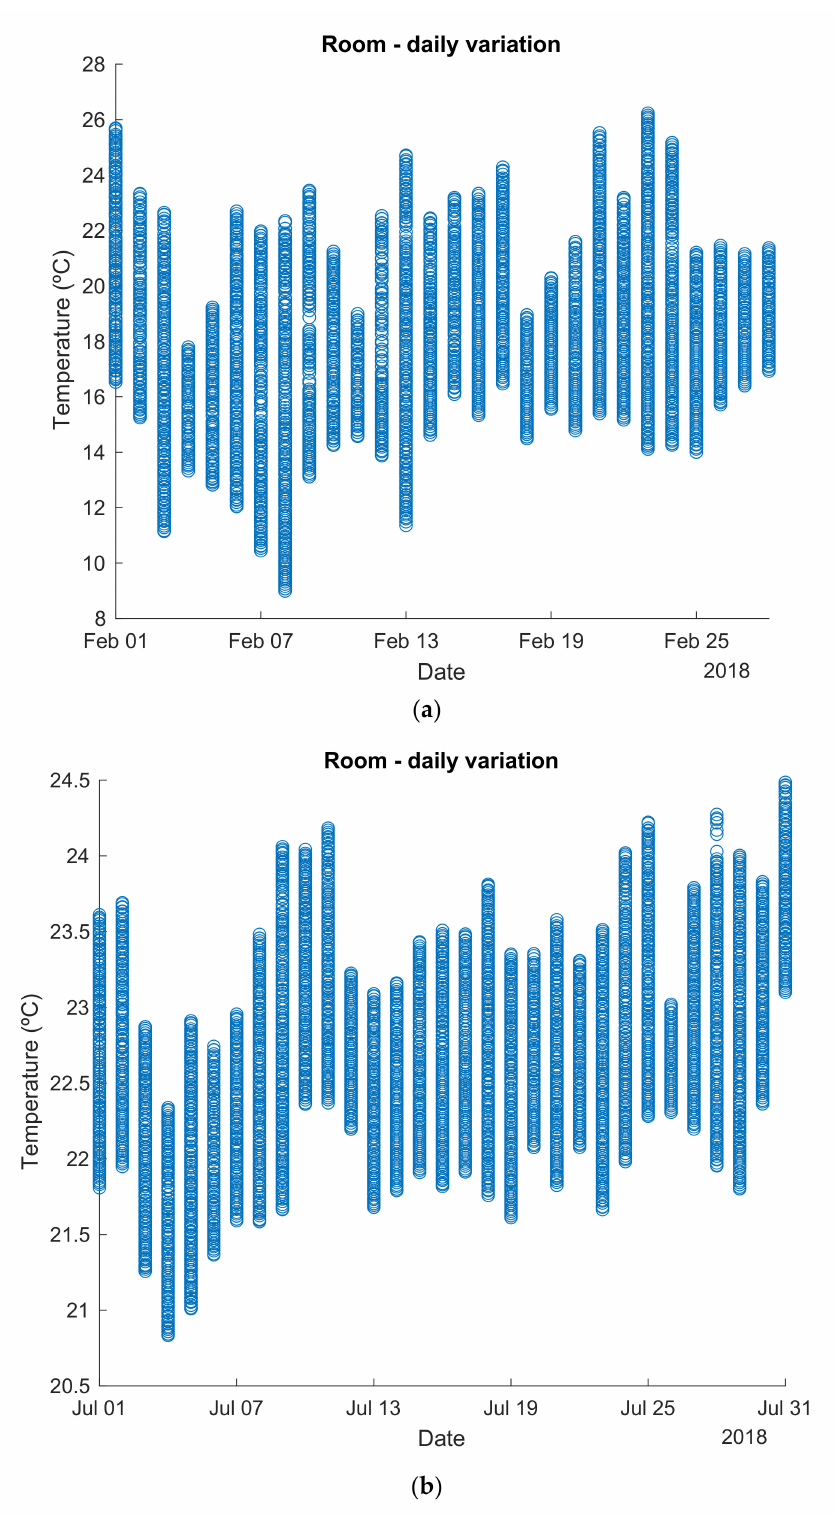
Figure A4. Detailed room temperature daily variation: ( a ) February/2018; ( b )